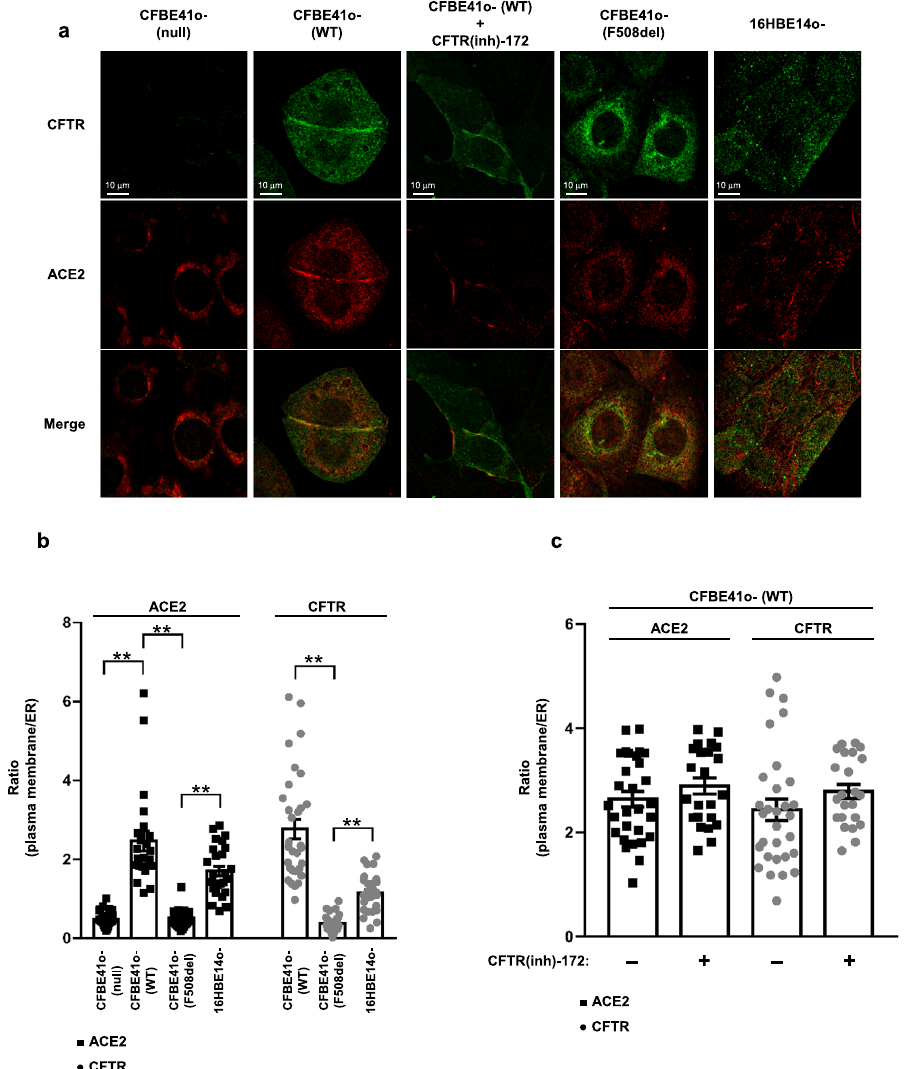
Fig. 3 | Localization of CFTR on the plasma membrane, but not its function, is essential for the subcellular localization of ACE2 on the cell surface. a Representative images of immuno fl uorescence detection of CFTR (green) and ACE2receptor(red)underbasalconditionsinCFBE41o-(null),CFBE41o-expressing wild-type CFTR (WT), or F508del- CFTR (F508del), and 16HBE14o- cells. CFBE41o- (WT) cells were incubated also with 5 μ M CFTR(inh)-172 for 24h. Images were acquired with a Zeiss LSM510 confocal microscope (scale bar: 10 µ m). b Quanti fi cation of the subcellular distribution of the ACE2 receptor (black) and